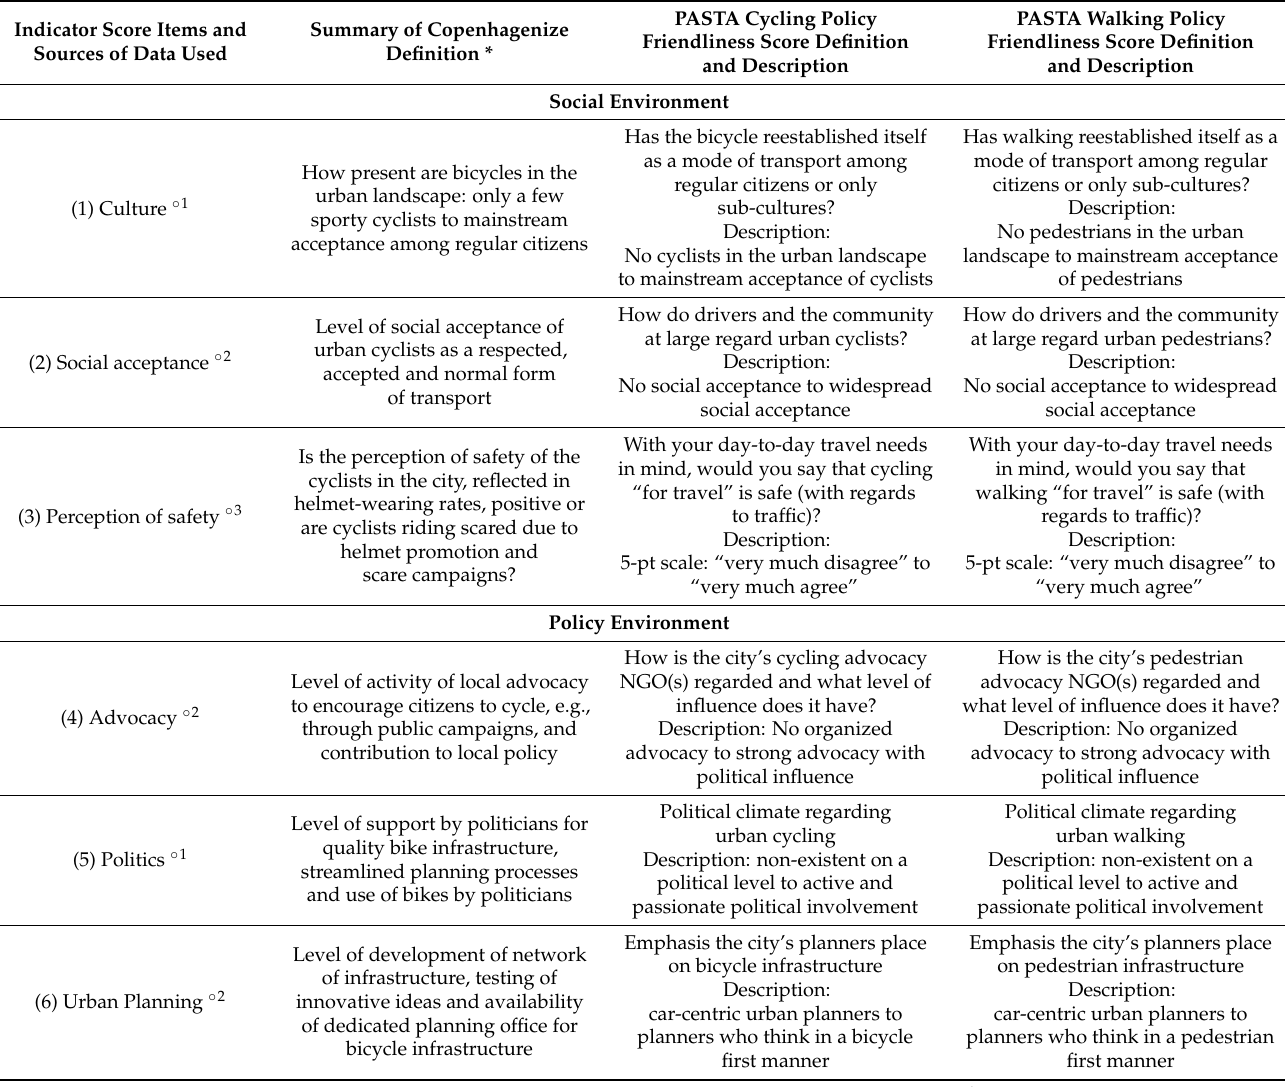
Table 1. Indicator score items with summary definitions of Copenhagenize, PASTA score definitions and description (scored from level zero—not existing, no evidence of recognition or reflection to level four—very much existing, great reflection and recognition, we could not wish for much